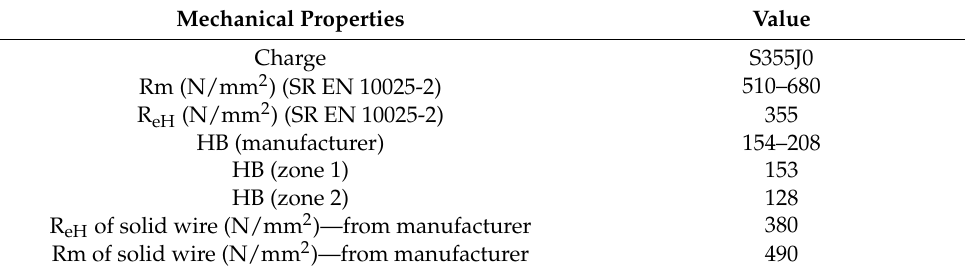
Table 3. Mechanical characteristics and average of hardness tests.